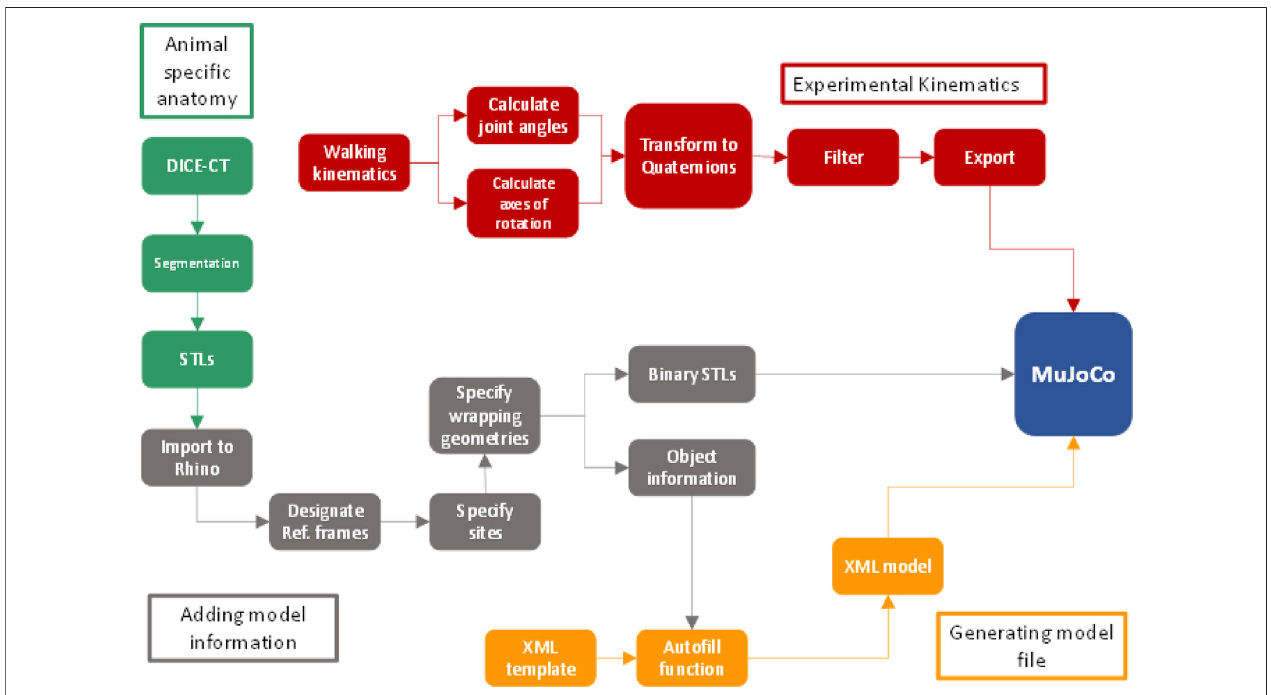
FIGURE 1 | Work fl ow diagram depicting the required steps for data collection from animal to